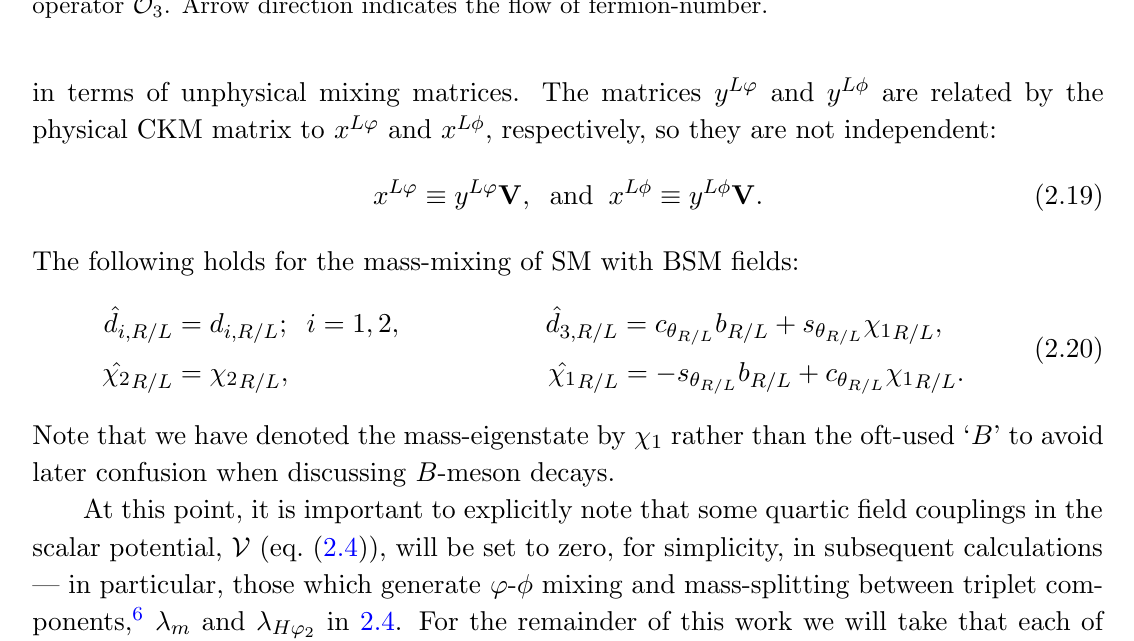
Figure 1. Dominant one-loop contributions to radiative neutrino mass generation, completions of operator O 3 . Arrow direction indicates the (cid:13)ow of